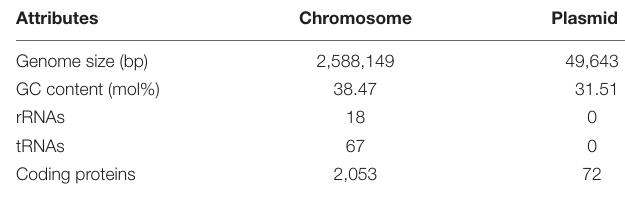
TABLE 2 | Features of Enterococcus faecalis Gr17